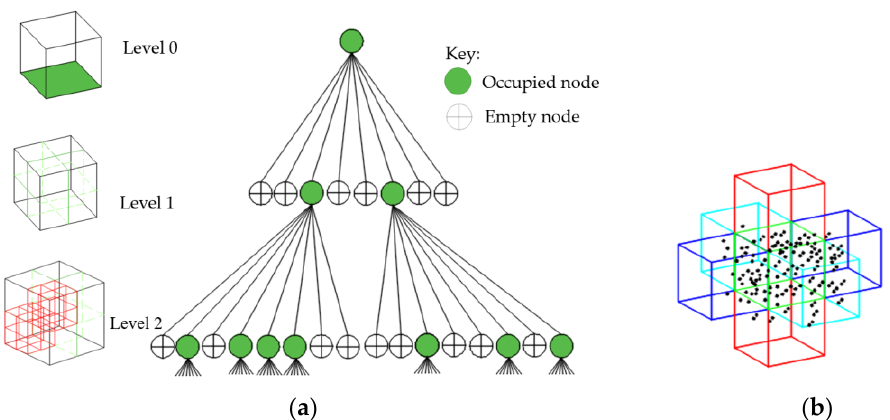
Figure 3. Point cloud subdivision: ( a ) octree structural framework; ( b ) abutting voxels for joining proximate planar patches.